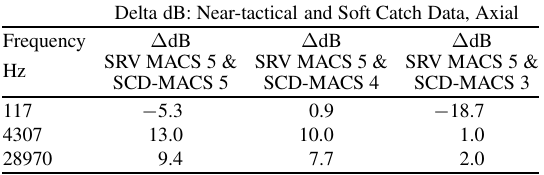
Table 4 Comparison of 95/50 normal tolerance limits, transverse accelerations Comparison of transverse limit accelerations, Gs, different frequencies